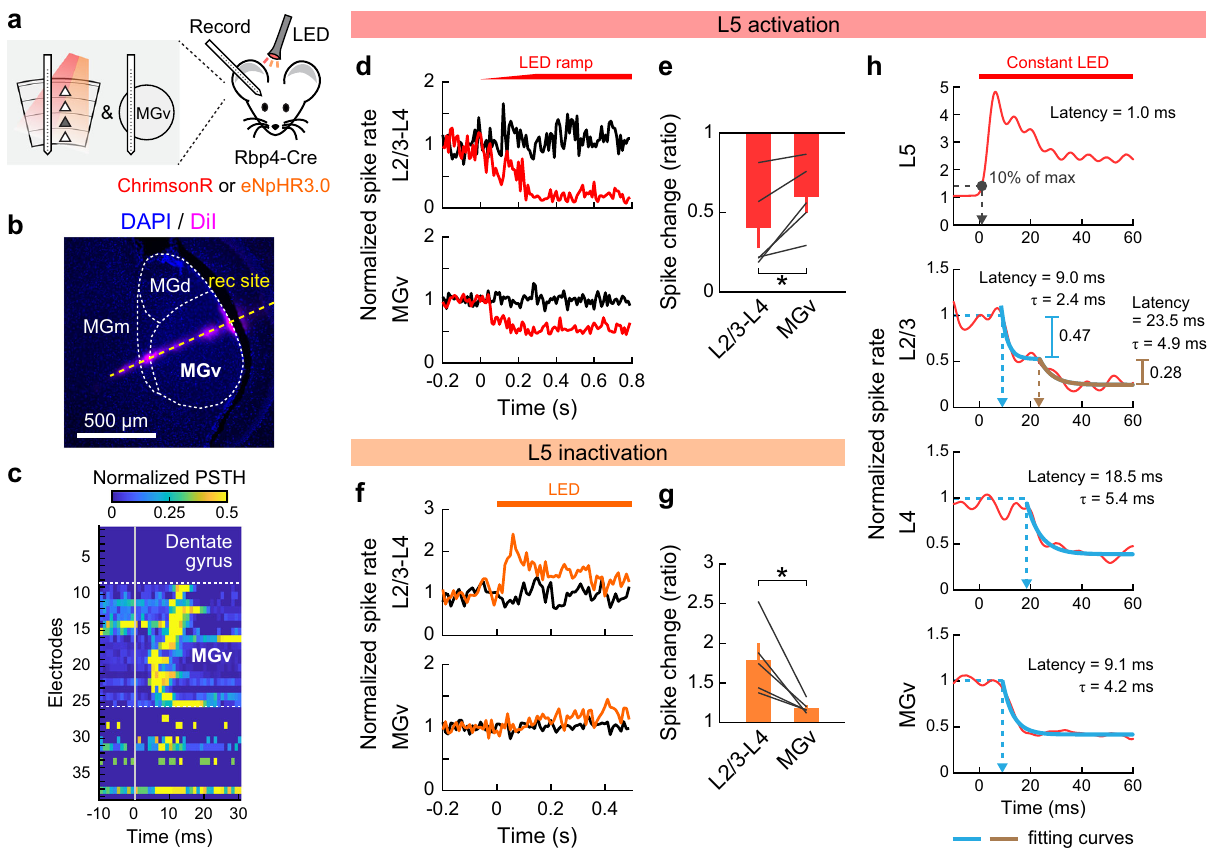
Fig. 5 L5 suppresses L2/3 via both intracortical and subcortical mechanisms. a Schematics for successive recordings of A1 and MGv in the same animal with optogenetic manipulation of L5. b Coronal section of auditory thalamus. Recording site (yellow dotted line) was identi fi ed by DiI signal. c Heat map showing normalized PSTH of click sound-evoked fi ring around MGv. PSTH was normalized to the maximum value in each channel to visualize the position dependence of spike latencies. Dotted lines indicate the identi fi ed borders of MGv. d , e Data for L5 activation with ChrimsonR. d Normalized PSTHs of multi-unit activity combining spikes in L2/3 – L4 (top) and MGv (bottom) with (red) and without (black) L5 activation in a representative mouse. Red bar, 625 nm LED. e Summary data comparing LED-dependent suppression of spontaneous fi ring between L2/3 – L4 and MGv ( n = 5 mice; * p = 0.033, two-sided paired t -test). Data are mean ± SEM. f , g Same as d , e but for L5 inactivation with eNpHR3 ( n = 5 mice). * p = 0.028. h Time course of spontaneous activity changes triggered by L5 activation using constant LED illumination without a ramp (red bar). Multi-unit activity in each layer was combined across mice after removing photoactivated units in L2/3, L4 ( n = 6 mice), and MGv ( n = 4 mice). Gray dot, delay for 10% maximum activation in L5. Blue lines, fi rst exponential fi t curves. Brown line, second exponential fi t curve. Fitting of L4 and MGv data with two exponential curves returned negligible second components. See Supplementary Data 1 for additional statistics. Source data are provided as a Source Data fi